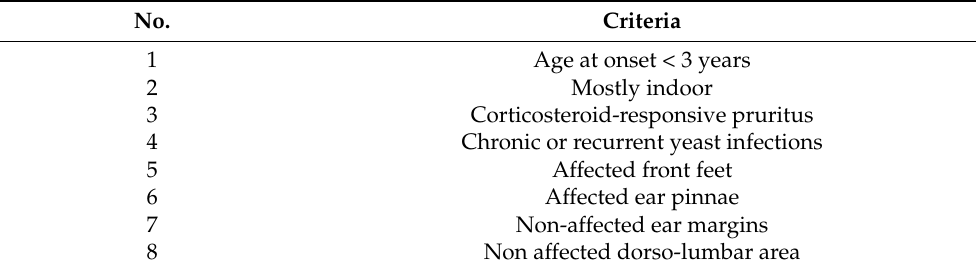
Table 1. Favrot’s criteria. Set 1 (use for clinical